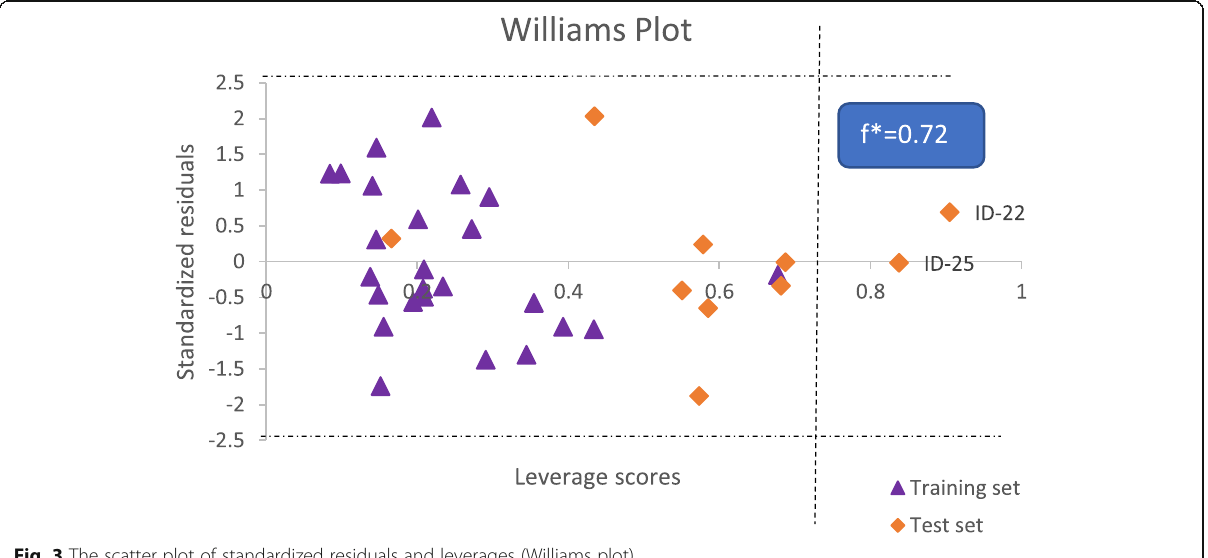
Fig. 3 The scatter plot of standardized residuals and leverages (Williams